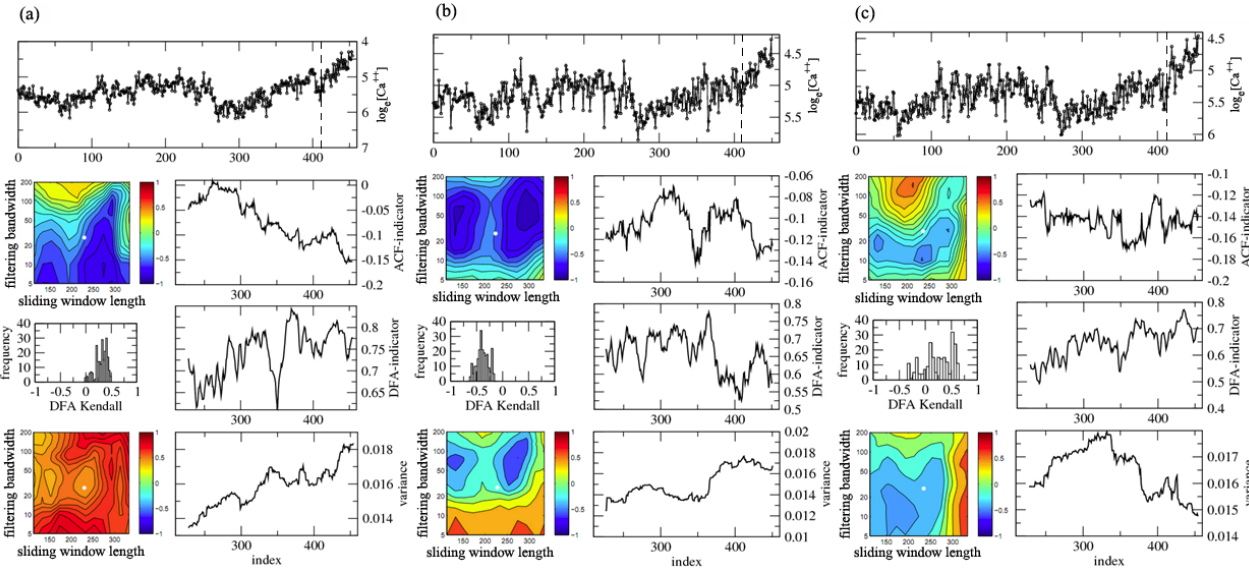
Fig. 8. Indicators of slowing down and changing variance of the stadial climate state, joining Greenland ice-core log e [Ca ++ ] records of the run-up to the Bølling warming to the Younger Dryas at the point indicated by the vertical dashed line: (a) GRIP (b) GISP2 (c) NGRIP. Panel descriptions are as in Fig.